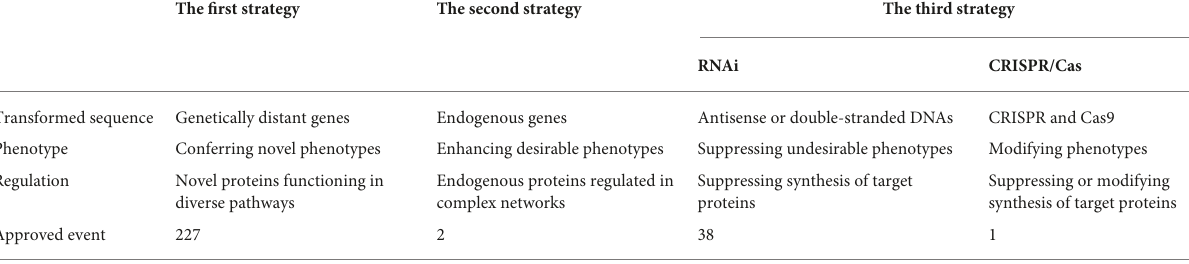
TABLE 2 Advantages and limitations of three transgenic